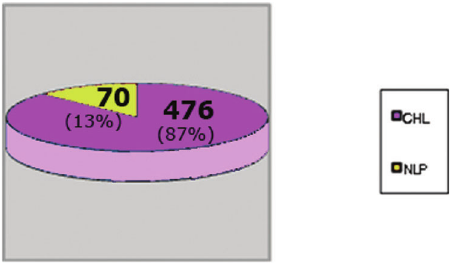
lymphoma; BL: Burkitt lymphoma; LL: lymphoblastic lymphoma.